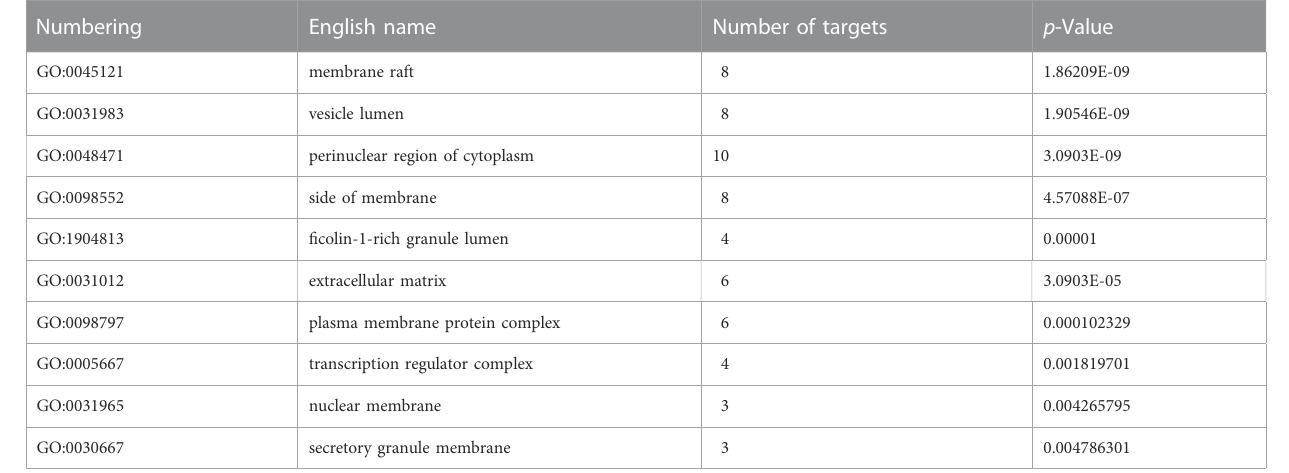
TABLE 7 Results from GO cell